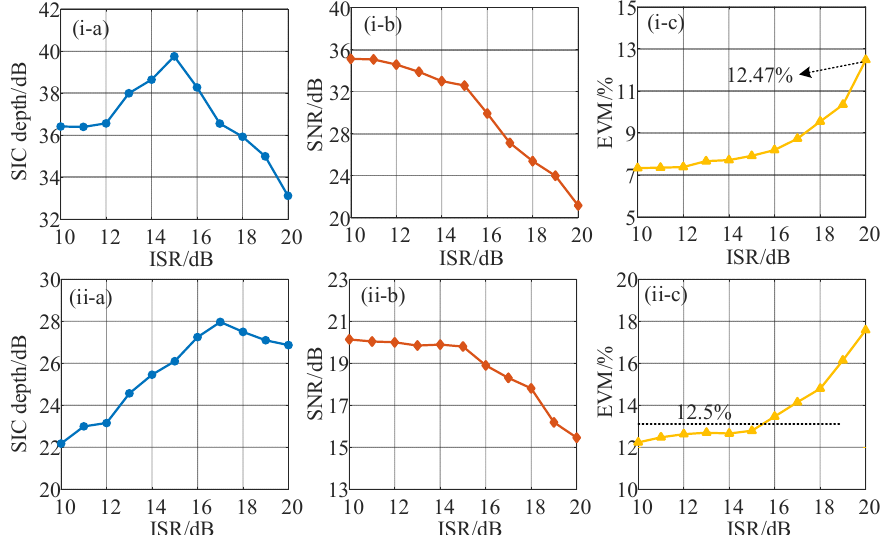
Figure 6. Measurement curves of ( a ) SIC depth, ( b ) SNR, and ( c ) EVM of received IF signal versus ISR with SIC enabled when the SOI was a 16 QAM modulated signal with a bandwidth of 500 MHz centered at ( i ) 12.5 GHz for fundamental down-conversion and ( ii ) 20.5 GHz for harmonic down- conversion.